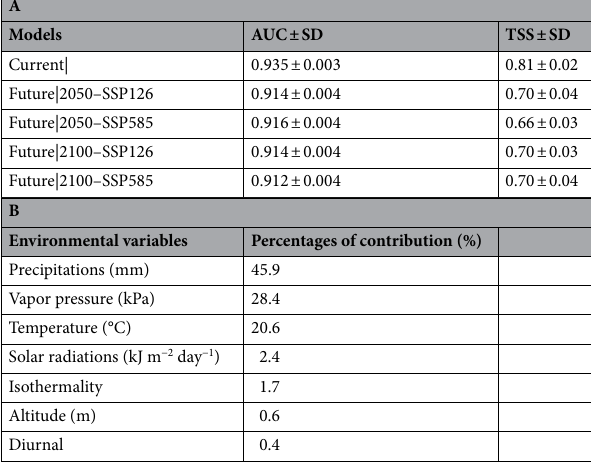
Table 1. ( A ) Model parameters and evaluation indicators. Area under the curve (AUC) and True Skilled Statistics (TSS), and standard deviation (SD) obtained for each scenario, and ( B ) percentage of contribution of environmental variables on suitable habitats for C. sowerbii under current